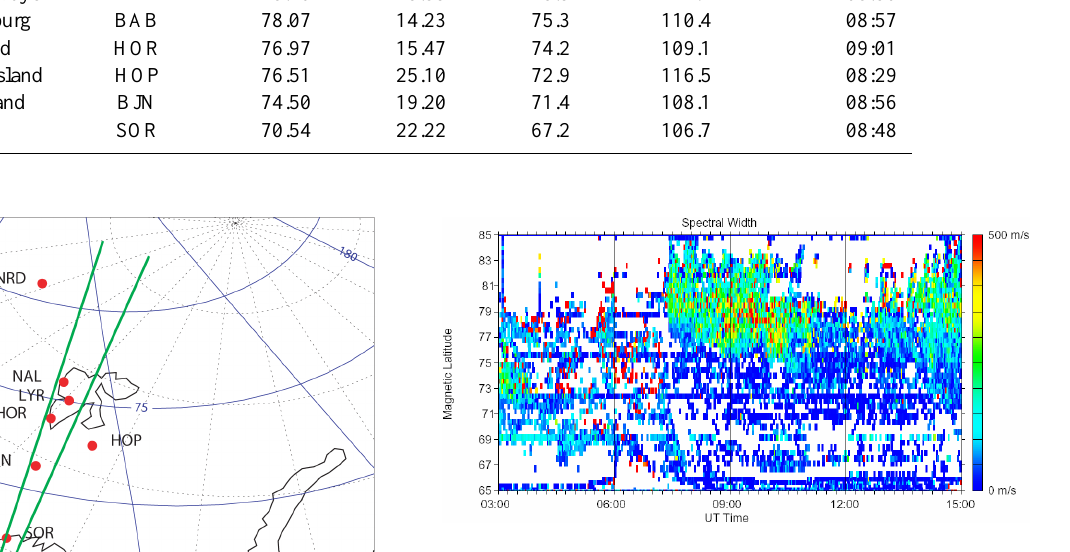
Figure 2. A magnetic local time–magnetic latitude snapshot of the line-of-sight Doppler velocity and spectral width from the Han- kasalmi SuperDARN radar from 03:00 to 15:00UT on 4 Jan- uary